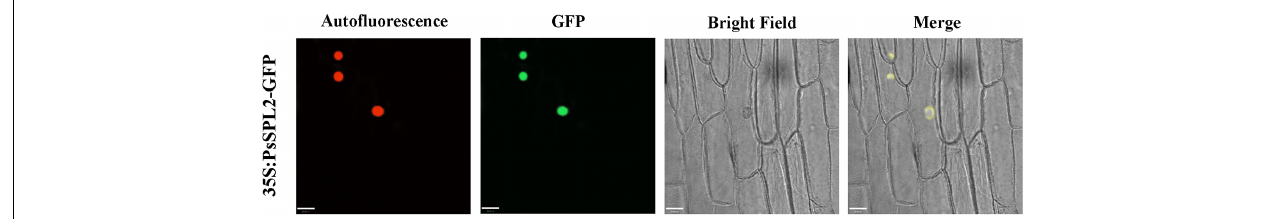
FIGURE 6 | Subcellular localization analysis of PsSPL2 fusion protein in onion epidermal cells.